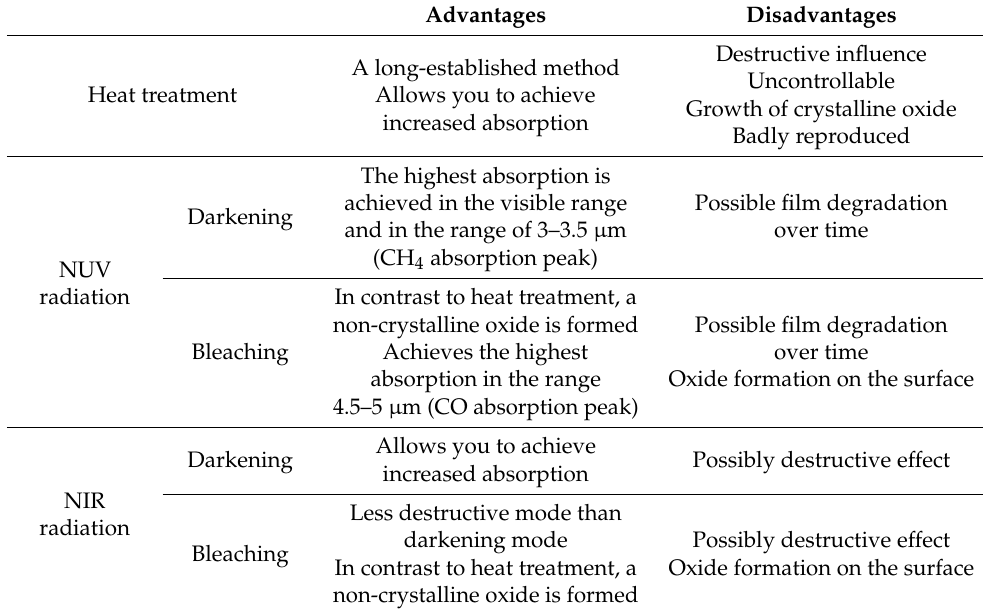
Table 3. Comparison of PbSe film processing